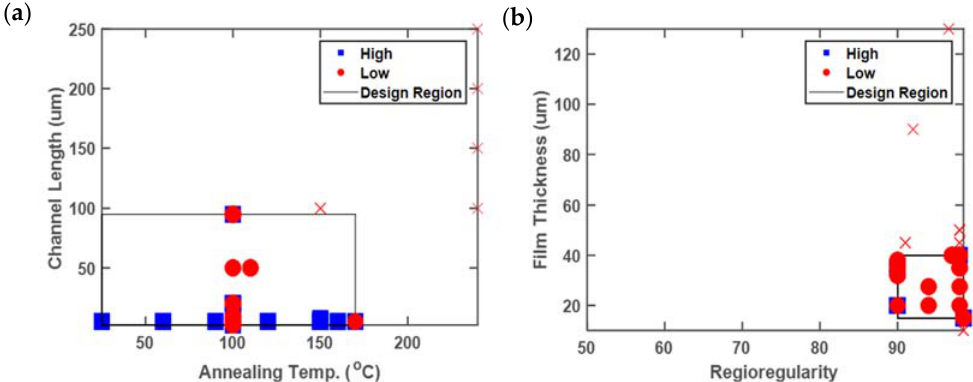
Figure 5. Illustrative two-dimensional plots indicating ( a ) limited collective screening of the entire design region (sparsity), and ( b ) inconsistent reporting and characterization. Axis values denote the full range of values present in the database.